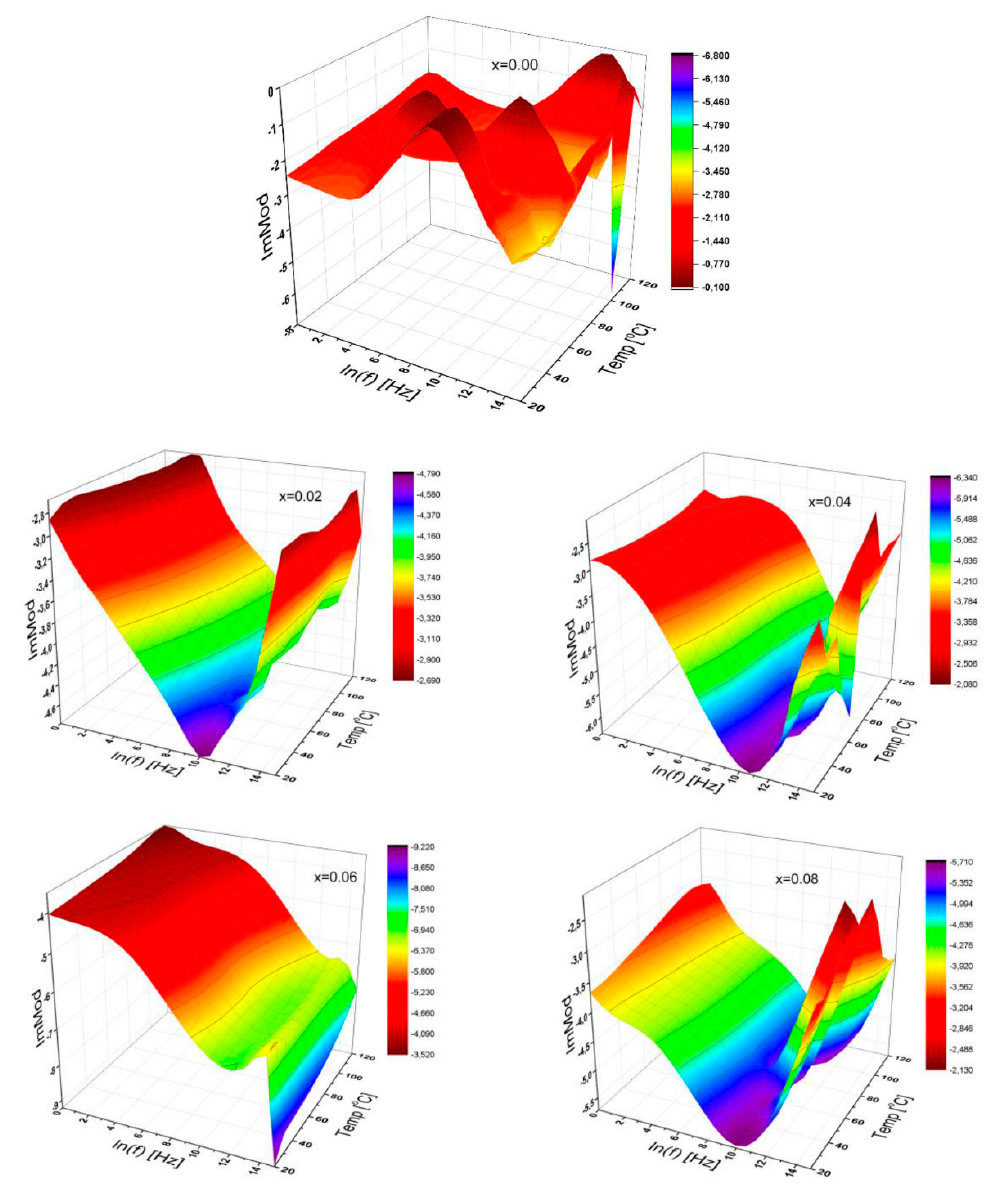
Figure 8. 3D characteristic plots of imaginary modulus of SrNb x Fe 12 − x O 19 (0.00 ≤ x ≤ 0.08) HFs for a variety of substitutional Nb ions ratio as functions of frequency up to 3 MHz, and for temperatures up to 120 °C.